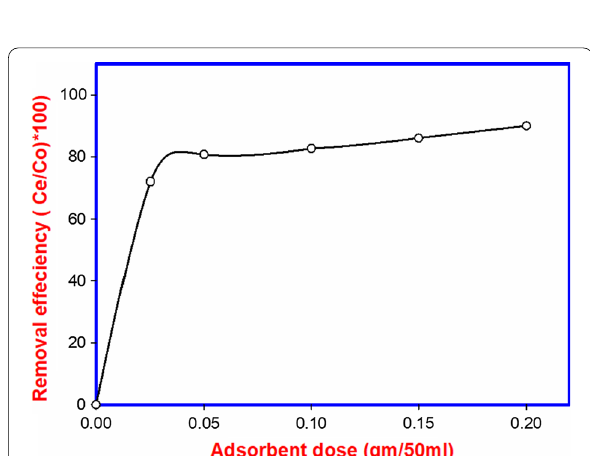
Fig. 8 Effect of adsorbent dose on the removal efficiency of C.V over sodium titanate nanotubes